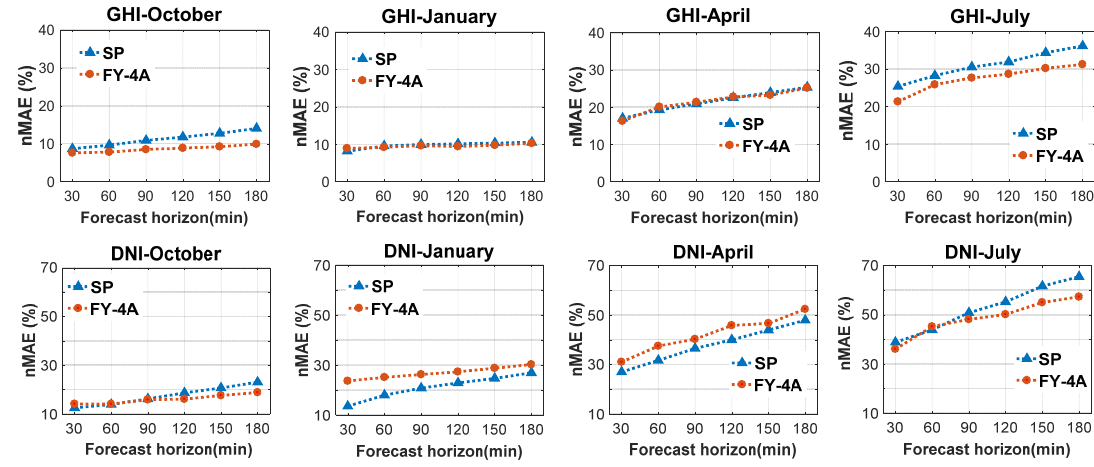
Figure 6. The nMAE values of forecasting models for GHI ( top ) and DNI ( bottom ) in various forecast horizon in four typical months (October 2018; January, April, and July 2019).